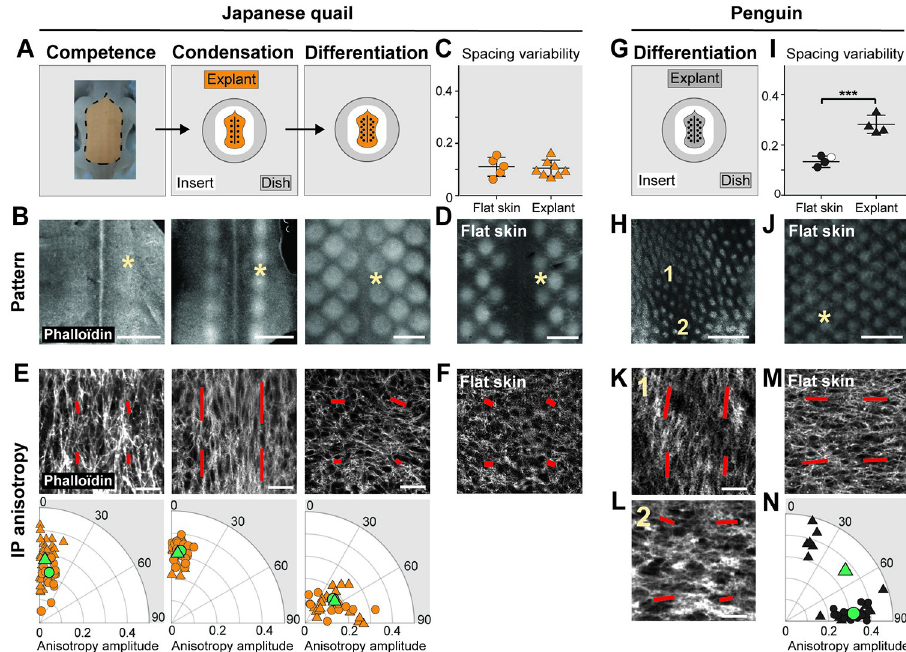
Fig 4. Dermal cell anisotropy amplitude correlates with pattern differences between ex vivo and in vivo conditions. (A) Dissected portions of dorsal embryonic skin (i.e., explant: shown here, a Japanese quail, orange region) at competence stage were placed on insert membranes (in white) in Petri dishes (in gray) and cultured to differentiation stage. (B) The 3,2 × views of phallo ï din-stained cultured explants of Japanese quail embryos show they retain proper dynamics of primordia pattern emergence. (C) Quantifications of spacing variability show that at differentiation stage, pattern fidelity was maintained in explants (triangles; n = 8) compared to flat skins (dots; n = 5; unpaired 2-tailed t test; p = 0.7791). (D) The 3,2 × view of a phallo ï din-stained Japanese quail flat skin. (E, F) Confocal views corresponding to the location of asterisks in (B) and (D) and respective quantifications (as described in Fig 3) of phallo ï din-stained inter-primordia dermis show that in Japanese quail explants (E, triangles), cells remain anisotropic at competence and condensation stage and isotropic at differentiation stage, similar to control flat skins (F, dots). (G) African penguin explants were cultured to differentiation stage. (H–J) The 3,2 × views of a phallo ï din-stained African penguin explant (H) and flat skin (J), and quantifications of spacing variability (I) show that in penguin explants, (triangles; n = 4), pattern fidelity was significantly impaired compared to control flat skins (dots; n = 3 for Gentoo penguins in black; n = 1 for African penguins in white, see Materials and methods; p = 0.0005). (K–M) The 40 × confocal views of phalloid ï n-stained explants showed that while cell shape anisotropy varied depending on location (2 positions are marked with (1) and (2) and shown in (K) and (L), respectively), it differed from that observed in flat skins (M). (N) Quantifications showed that the amplitude and orientation of cell shape anisotropy orientation were highly variable in explants as shown by large distribution of individual values (small triangles), global dorso-ventral anisotropy being lost (large triangle), compared to control flat skins (dots). Small data shapes are individual values, large data shapes (in green) are averaged values. The data underlying this figure can be found at 10.5281/ zenodo.7006365. Error bars: mean with standard deviation. Scale bars: 500 μ m (primordia pattern), 20 μ m (anisotropy).